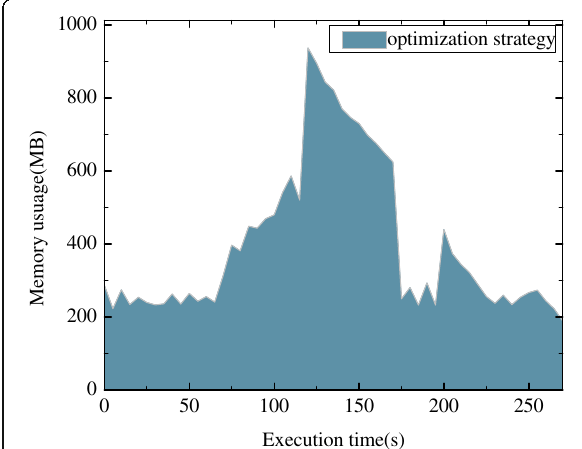
Fig. 5 The memory utilization of K-Means